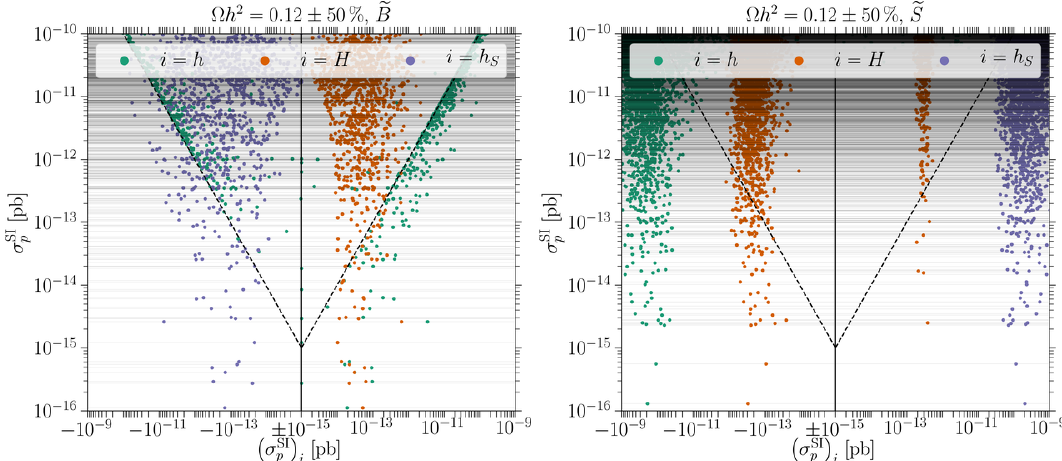
(cid:0) (cid:1) Figure 6 . SIDD cross section (cid:27) SI vs. the contribution (cid:27) SI assuming only one CP-even Higgs p p i mass eigenstate h i = f h; H; h S g multiplied by the sign of its amplitude, cf. eq. (2.61). The dashed (cid:12) (cid:12) (cid:1) (cid:12) (cid:12)(cid:0) (cid:27) SI (cid:12) SI diagonal lines indicate . Hence, if the contribution from one of the h i lies on the (cid:12) = (cid:27) p p i diagonal lines and the contributions from the remaining mass eigenstates lie within the triangle, the SIDD cross section is dominantly mediated by that mass eigenstate. On the contrary, if the contributions lie outside the dashed diagonal lines, they interfere destructively to yield the total SIDD cross section. The left (right) panel shows parameter points where the lightest neutralino is bino (singlino) like. For both cases, we show points from our parameter scan which satisfy (cid:10) h 2 = 0 : 12 (cid:6) 50